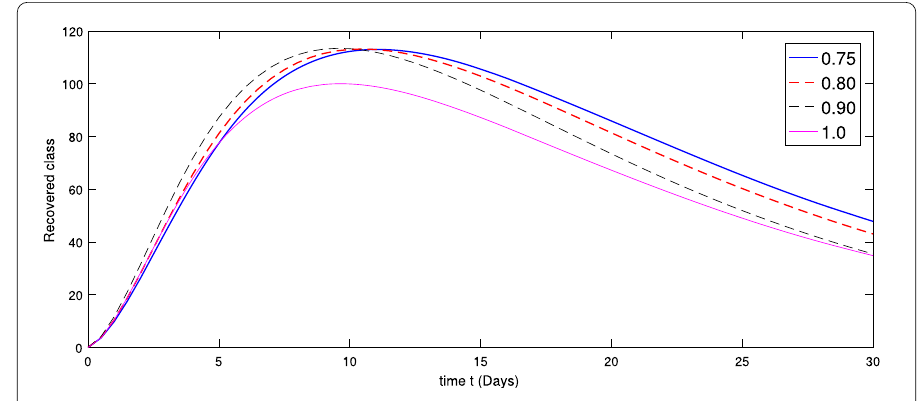
Figure 6 Graphical representation of approximate solutions up to five terms of recovered population R ( t ) at different fractional order of the considered model